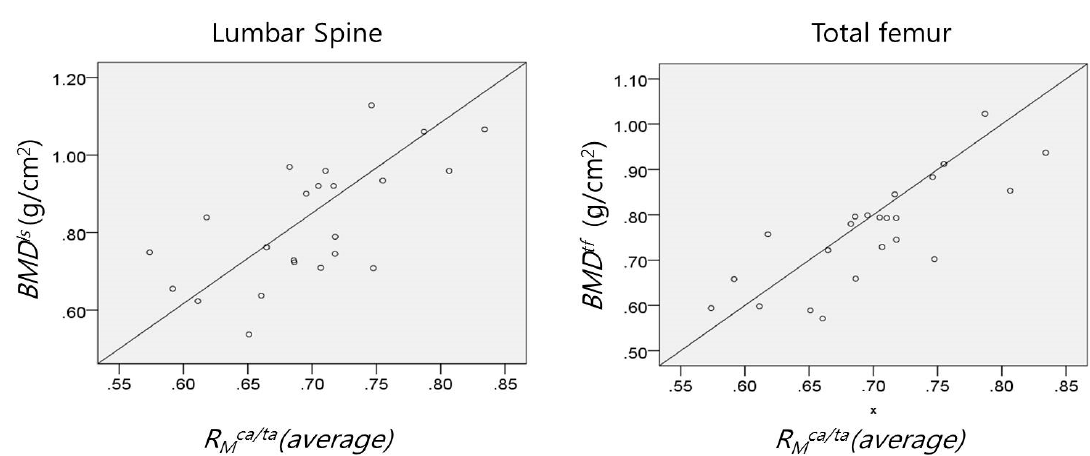
Figure 6. BMD ls and BMD tf and are correlated with R Mca/ta ( average ). The correlation coefficients are r = 0.647 and r = 0.792, respectively. Note that the correlation of BMD f corresponds to r = 0.857.